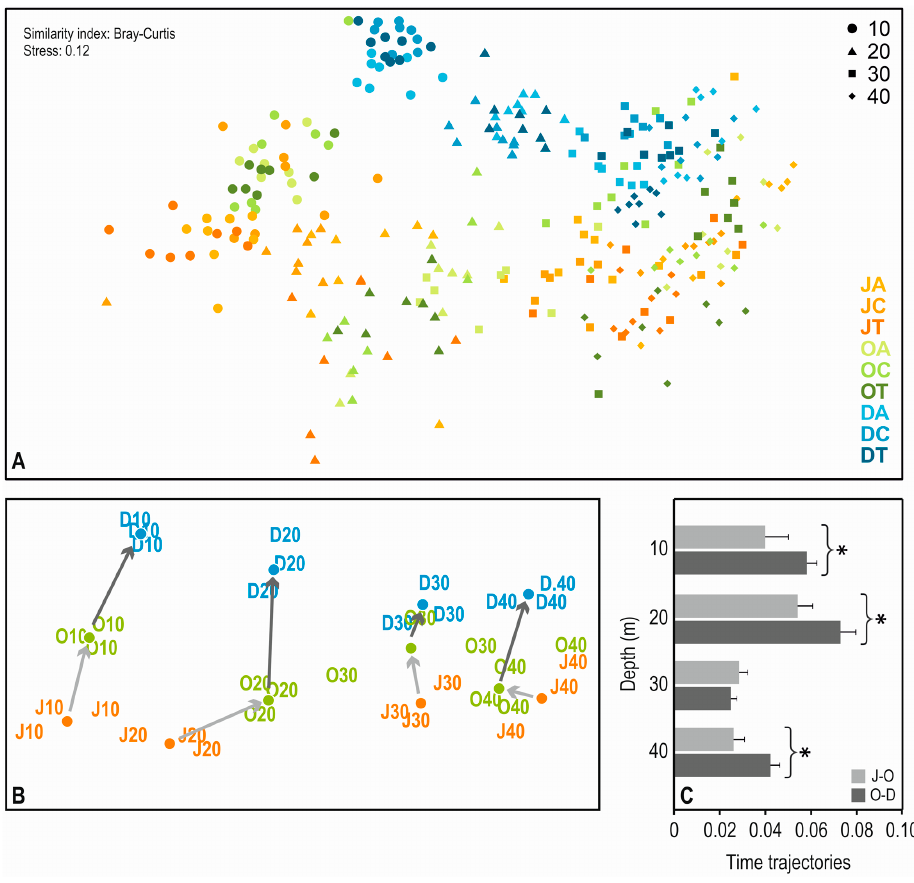
Table 1. The 2018 thermal anomalies (in bold) detected by applying the method proposed by Jiménez-Muñoz et al. [47].